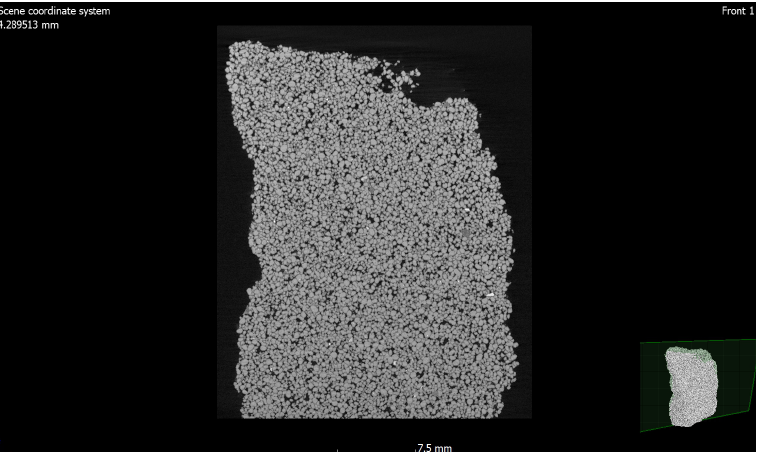
Energies 2023 , 16 , x FOR PEER REVIEW Figure 15. Image of the porous structure of traditional (reference) silicate brick with 90% QS.